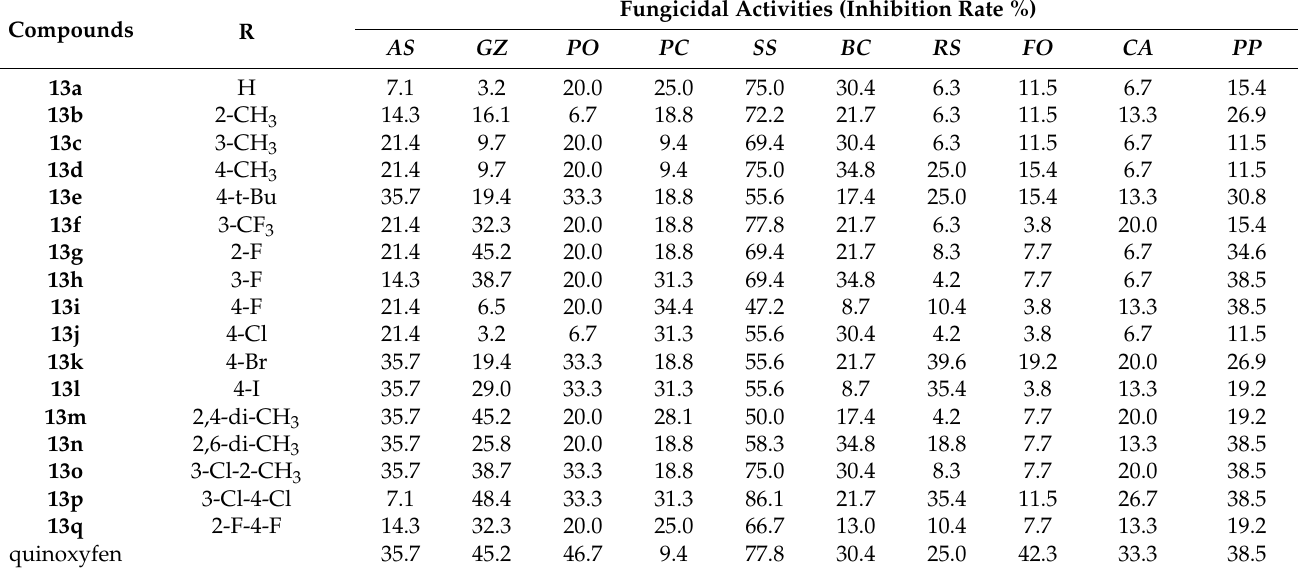
Table 2. Fungicidal activities of compounds 13a – 13q at 50 mg/L.